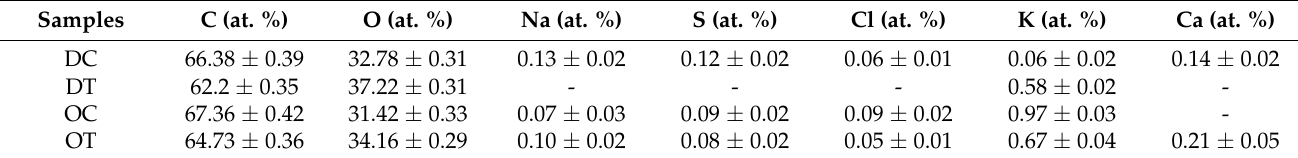
Table 2. SEM-EDX elemental analysis.